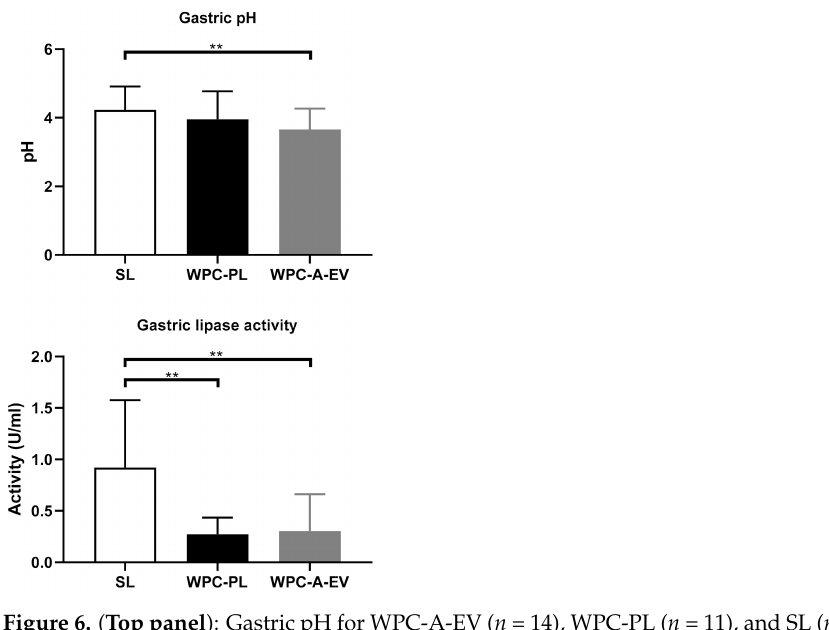
Figure 6. ( Top panel ): Gastric pH for WPC-A-EV ( n = 14), WPC-PL ( n = 11), and SL ( n = 17) in gastric content collected post euthanasia. ( Bottom panel ): Gastric lipase activity for WPC-A-EV ( n = 13), WPC-PL ( n = 11), and SL ( n = 16) in gastric content collected post euthanasia. ** p <